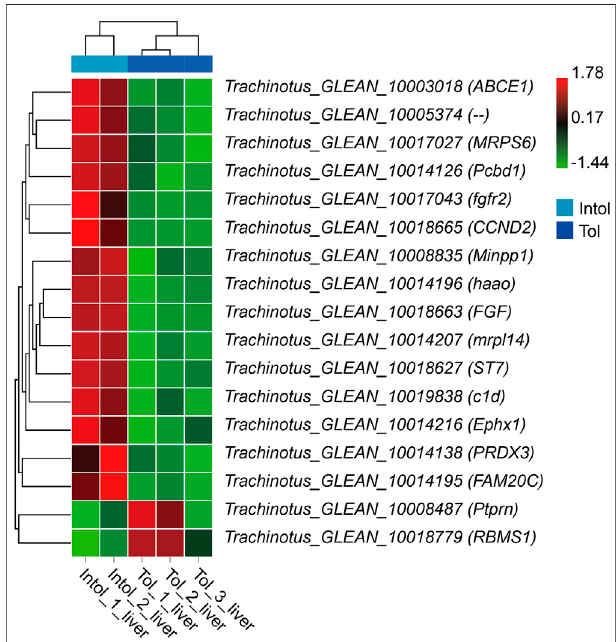
FIGURE 9 | Heat map of 17 differentially expressed candidate gene expression